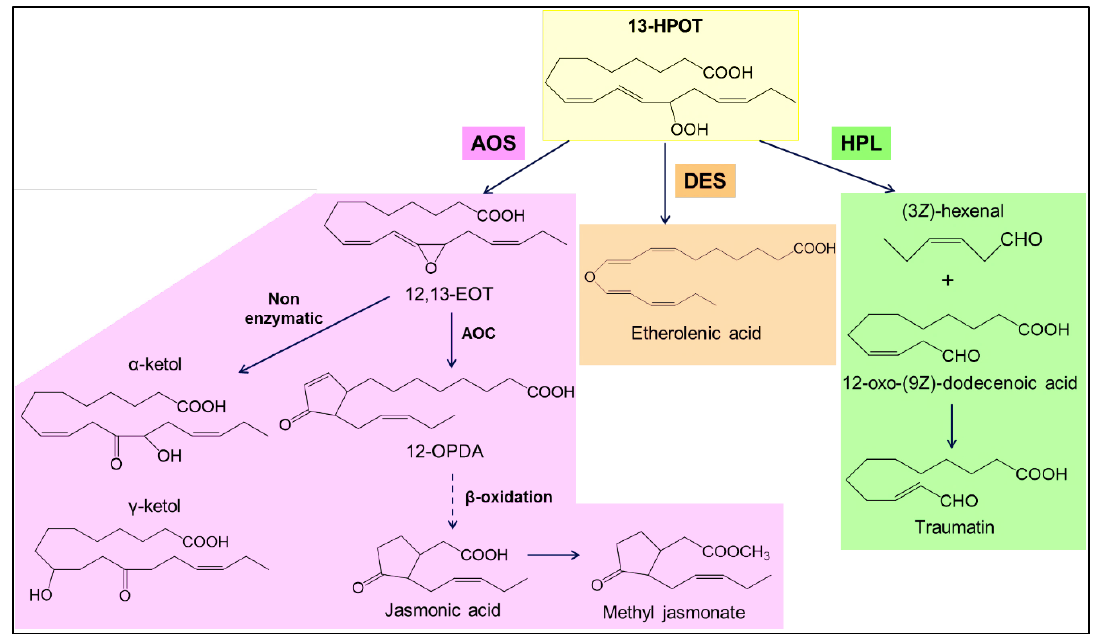
Figure 2. Phytooxylipins produced from 13-hydroperoxy-(9 Z ,11 E ,15 Z )-octadecatrienoic acid (13-HPOT) by the enzymes of the CYP74 family. 13-HPOT can be metabolized by CYP74 family enzymes. AOS produces an unstable allene oxide: (12,13)-epoxyoctadecatrienoic acid (12,13-EOT), which can hydrolyze spontaneously to α - and γ -ketols, or be cyclized by allene oxide cyclase (AOC) to 12-Oxo-(10 Z ,15 Z )-phytodienoic acid (12-OPDA), which can be converted into jasmonates after three cycles of β -oxidation. DES generates the etherolenic acid. HPL produces an aldehyde: (3 Z )-hexenal, and an oxoacid: 12-oxo-(9 Z )-dodecenoic acid which is the precursor of traumatin.